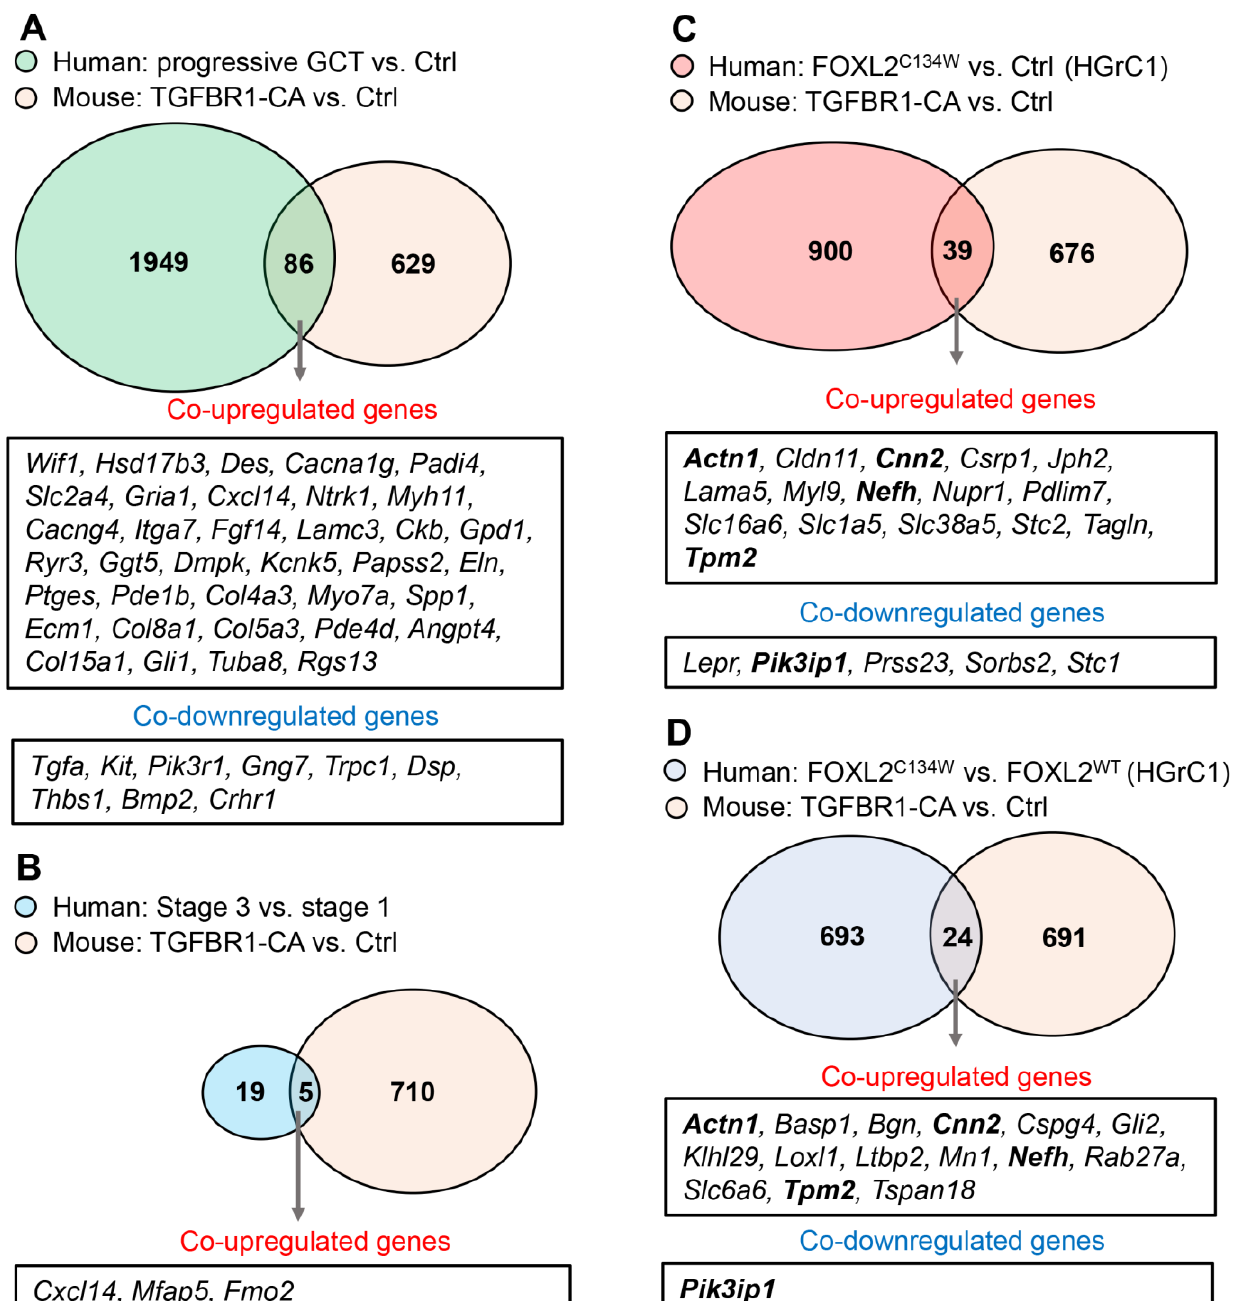
Figure 5. Identification of common regulators of ovarian GCT development between mice and hu- mans. ( A ) Comparison of DE genes in TGFBR1-CA ovaries with those between the human progressive GCT and normal ovaries. Gene expression of human GCTs was previously reported [28] . ( B ) Comparison of DE genes in TGFBR1-CA ovaries with those between advanced stage and early stage GCTs. Identification of tumor stage-associated genes was previously documented [27]. ( C , D ) Comparison of differentially expressed genes in TGFBR1-CA ovaries with those between FOXL2 C134W and vehicle or FOXL2 WT -transfected HGrC1. An immortalized human granulosa cell line was used to reveal genes associated with FOXL2 mutation [11] . Overlapping genes between panels ( C , D ) are bolded. Second, we compare our DE gene list with the 24 genes differentially expressed be- tween the advanced stage GCT and early stage GCTs reported previously [27]. The analysis identified three co-upregulated genes that include Cxcl14 , the flavin containing